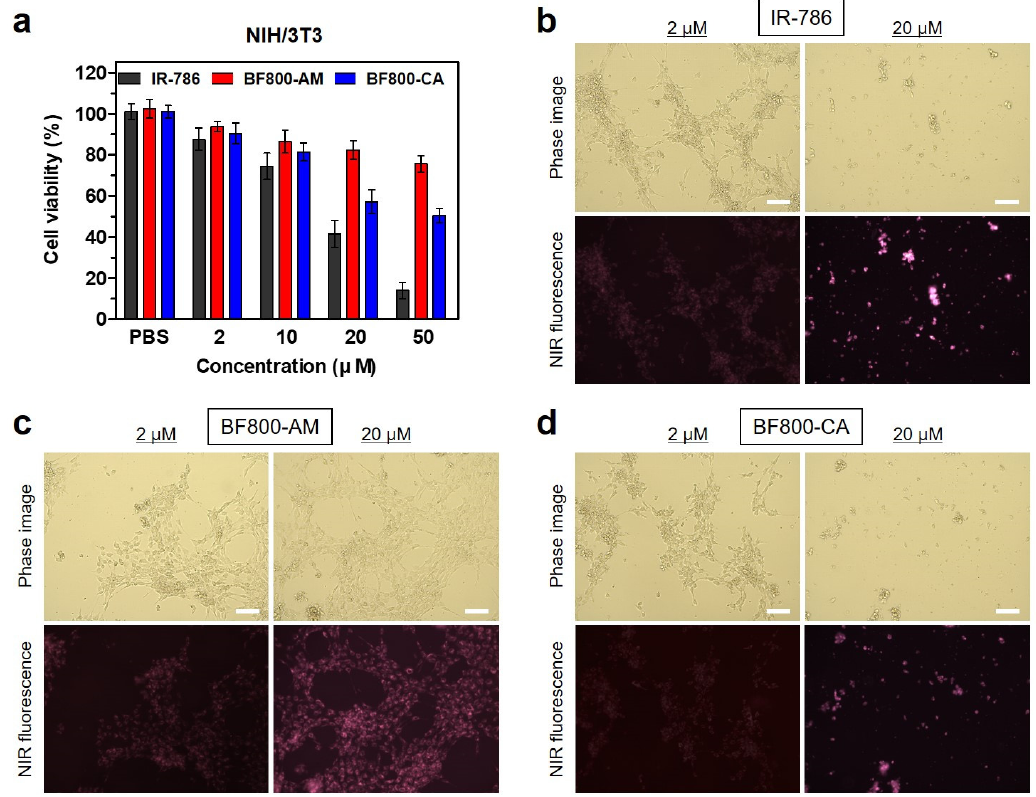
Figure 4. ( a ) Cell viability assay of each NIR dye using NIH/3T3 cells. Percentage cytotoxicity was determined after 24 h of treatment with various concentrations of each NIR dye. Live cell binding of ( b ) IR-786, ( c ) BF800-AM, and ( d ) BF800-CA NIR dyes in NIH/3T3 cells. The phase contrast and NIR fluorescence images of the cell line were obtained using 2 and 20 µM of each NIR dye. Images are representative of three independent experiments. All NIR fluorescence images have identical exposure times and normalization. Scale bars = 100 µm.